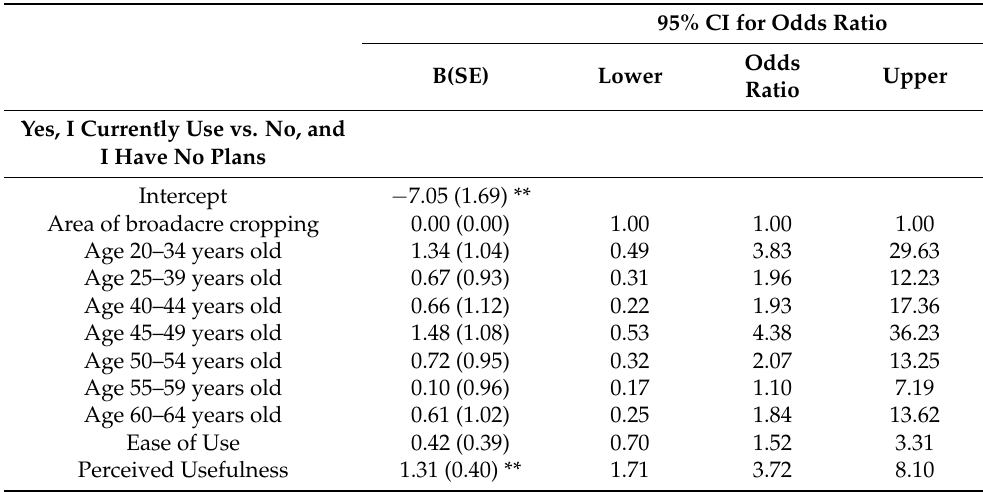
Table 5. Multinomial logistic regression results. Bold denotes statistically similar results where * = p < 0.05 and ** = p <